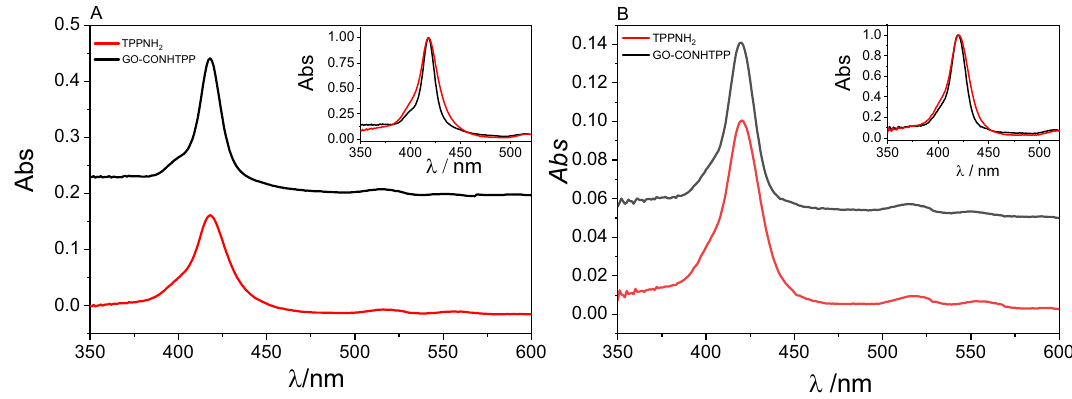
Figure 3. Absorption spectra of free TPPNH 2 (red curve), TPPNH 2 covalently bound to GO (black curve) in: ( A ) DMF, ( B ) DMF-H 2 O (1:2 v/v). Insets: Normalized absorption spectra of TPPNH 2 and GO-CONHTPP.